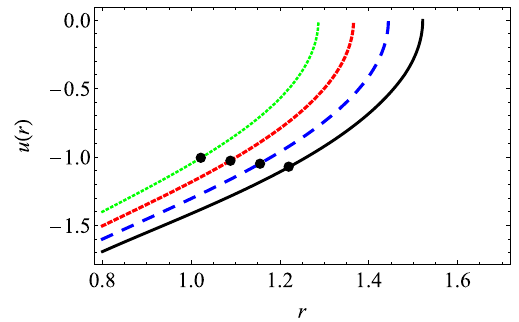
Fig. 1 Radial velocity for C 1 = − 1, C 2 = 1 (cid:9) = 0 . 00 (black solid line), (cid:9) = 0 . 1 (dashed blue line), (cid:9) = 0 . 20 (short dashed red line) and (cid:9) = 0 . 30 (dotted green line). The other values have been taken as unity. The dots depicts the critical points of each solution. See text for details Table 1 Horizon radius r H and critical radius r critic